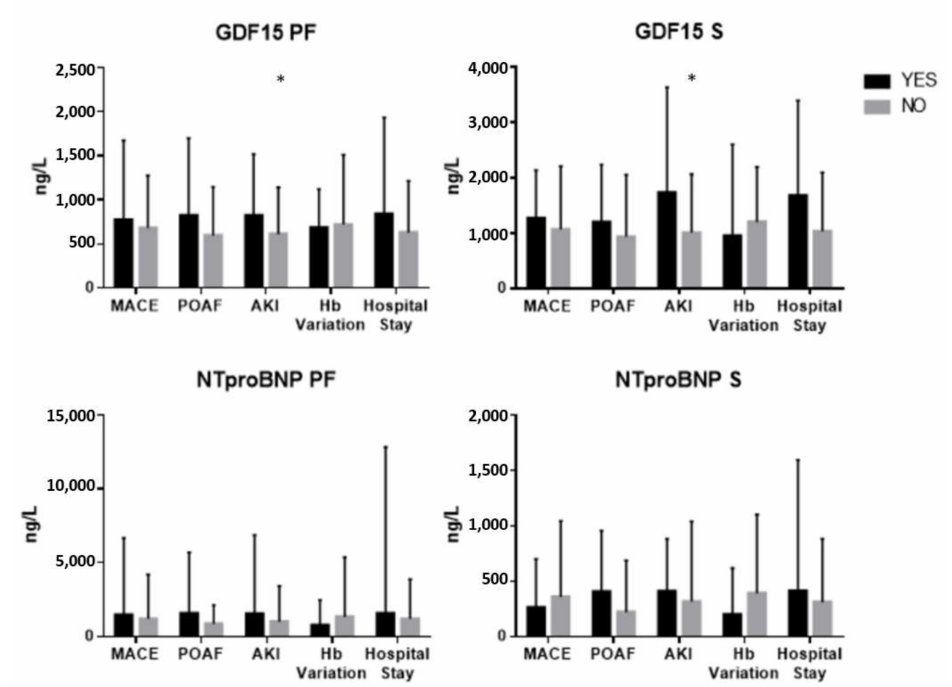
Figure 4. Differences between pericardial fluid and serum NT-pro-BNP and GDF-15 and 30-day postoperative outcomes. Mann–Whitney U test was used for all comparisons; * p < 0.05. Sample